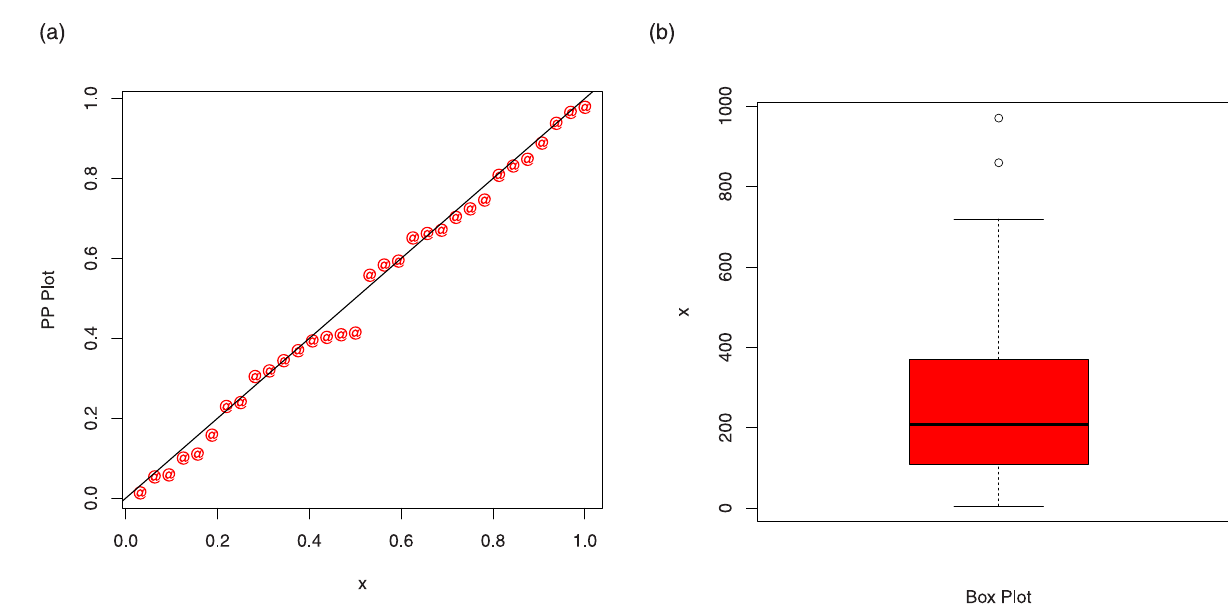
Fig 12. PP plot of the TI-HTW distribution and the box plot for data 3.